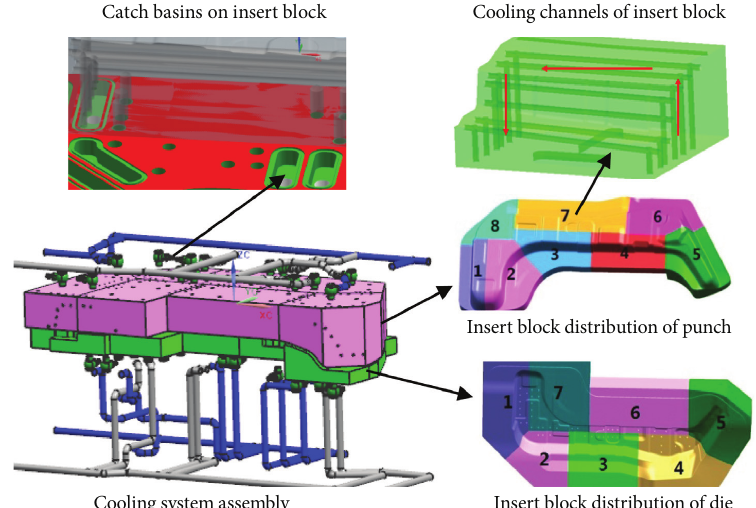
Figure 2: Cooling system in insert hot stamping